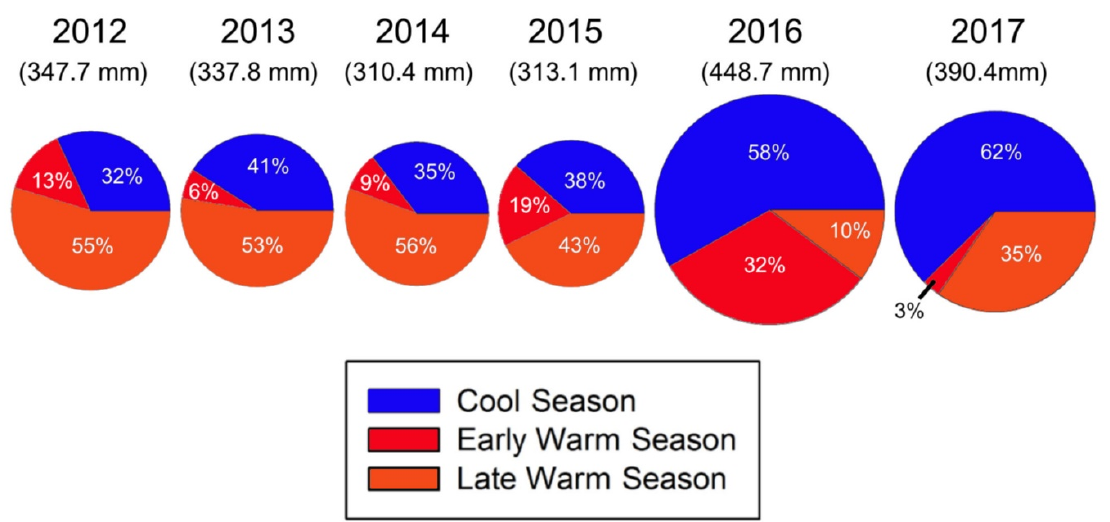
Table 1. Summary of seasonal and water year precipitation totals (PPT) at our study site in the Sheep Range of southern Nevada (Figure 1).